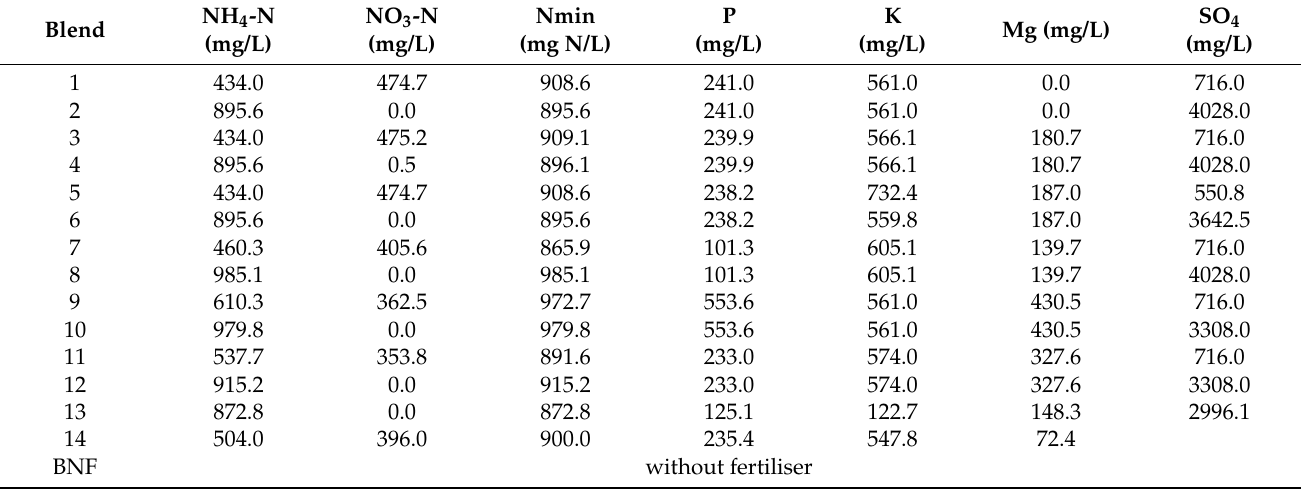
Table A2. Theoretical nutrient composition for each blend based in the amounts described in Table